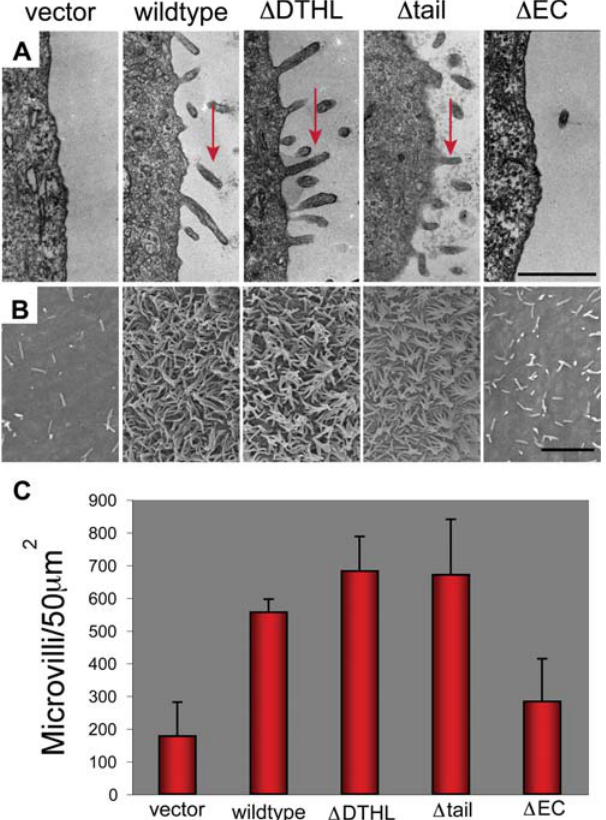
Figure 8. Podocalyxin’s extracellular domain and the first four amino acids of its cytoplasmic tail are necessary and sufficient for microvillus formation. (A) TEM images of MCF-7 cells transfected with vector or full-length and mutant Podocalyxin. Vertical slices are shown near the apical cell surface with some of the numerous additional microvilli labeled with red arrows. Scale bar: 1 m m. (B) SEM images at the apical surface of transfected MCF-7 cells with microvilli evident as thin surface projections. Scale bar: 2 m m. (C) Microvilli in six 50 m m 2 fields were enumerated and graphed. Averages are shown; error bars represent standard deviation. T-tests were used to show statistically significant differences between vector and Podocalyxin-transfected cells, and between wildtype Podocalyxin and D EC-transfected cells with p , 0.003 in all cases. Representative of two independent experiments.